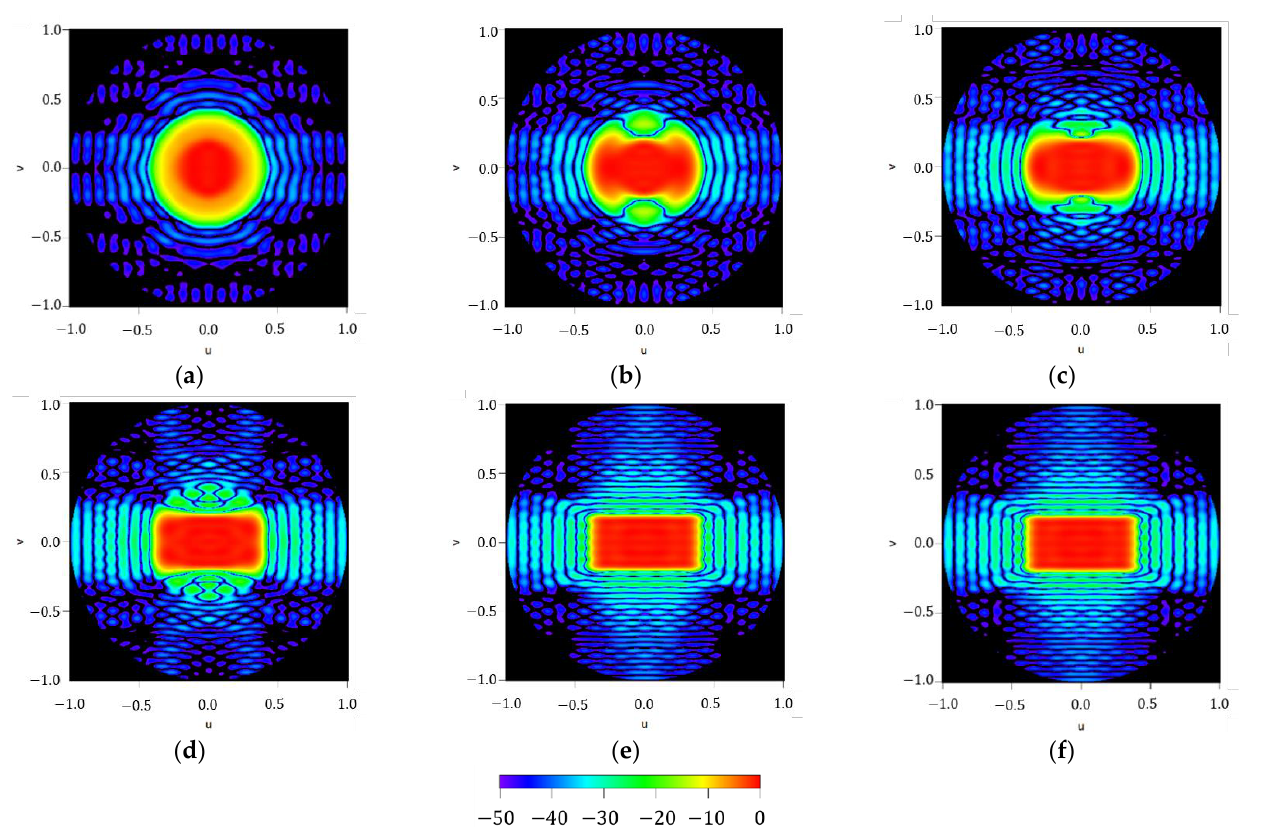
Figure 10. Figure series illustrating the iterative process devoted to generate a rectangular footprint by increasing the maximum order of the aperture distribution series N K max described in (7): ( a ) N K max = 0, ( b ) N K max = 2, ( c ) N K max = 4, ( d ) N K max = 8, ( e ) N K max = 32, and ( f ) N K max = 36. All the interpolated plots described here have a threshold level set at − 50 dB, for the normalized far-field power.